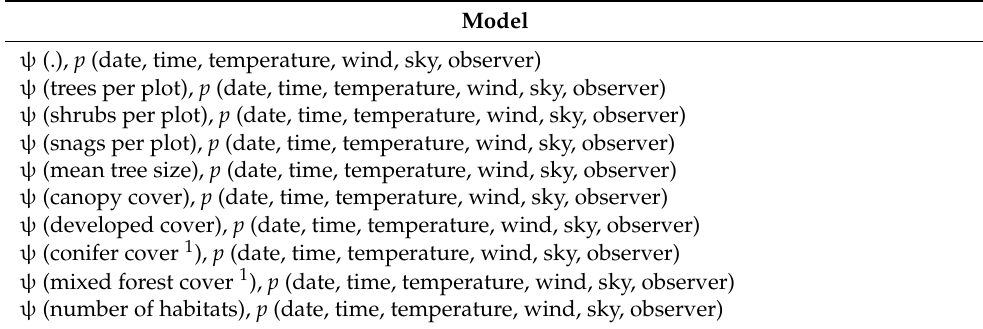
Table 2. Occupancy models used to examine the relative roles of human disturbance vs. alteration of habitat structure in influencing avian communities in exurban subdivisions in Essex County, NY and Madison County, MT; ψ = probability of occupancy (use), p = probability of detection.